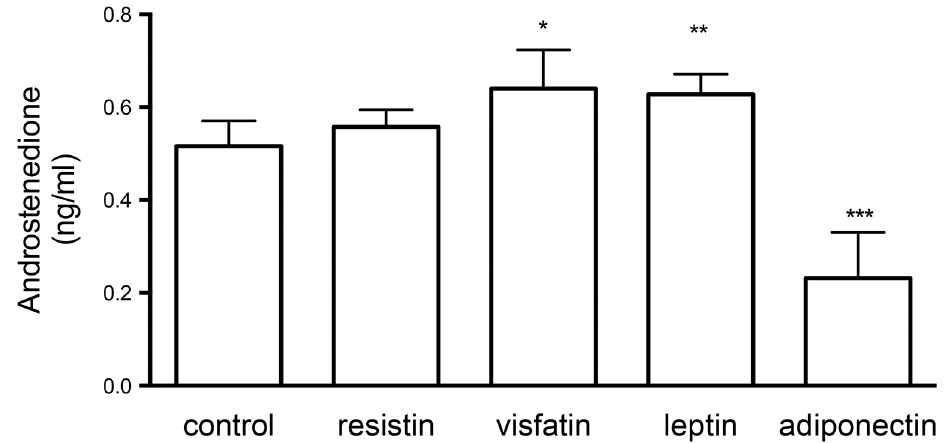
Figure 2. Effects of the adipokines resistin, visfatin, leptin, and adiponectin on androstenedione production in vitro in the presence of LH: compared to control cells, adiponectin treatment (3μg/mL) decreased levels of androstenedione in medium (****p= <0.0001) when bovine theca cells were treated with LH and insulin (both at 100 ng/mL). Small stimulatory effects of leptin and visfatin were also observed. The concentrations of adipokines were chosen on the basis of the relative serum levels in normal women. Data shown are mean+SD. doi: